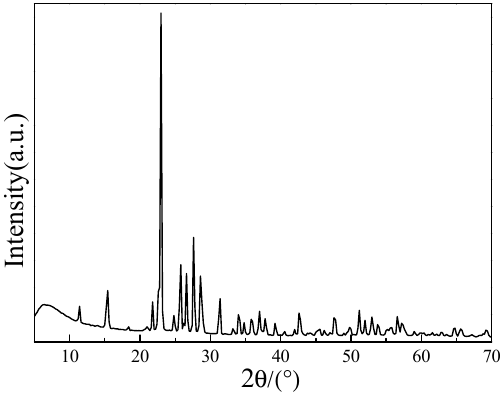
Figure 7. XRD of the product from catalytic oxidation of H 2 S by homogeneous mixtures at x (H 2 O) = 5.88%.